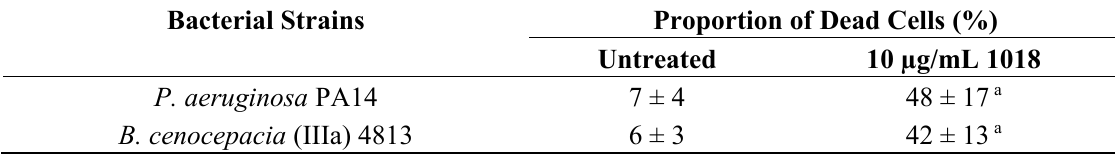
Table 3. Proportion of dead biofilm cells in hydroxyapatite plates after treatment with sub-MIC levels of peptide 1018. Biofilms were grown in HA discs for 3 days and treated with peptide 1018 every 24 h. After scanning confocal microscopy the volume ratio of red fluorescence (due to the dead cell stain propidium iodide to green (all bacteria stain Syto-9) plus red fluorescence indicated the proportion of killed cells. Three independent assays were performed. Different superscript letters indicate statistically significant differences between groups ( p < 0.05). Bacterial Strains Proportion of Dead Cells